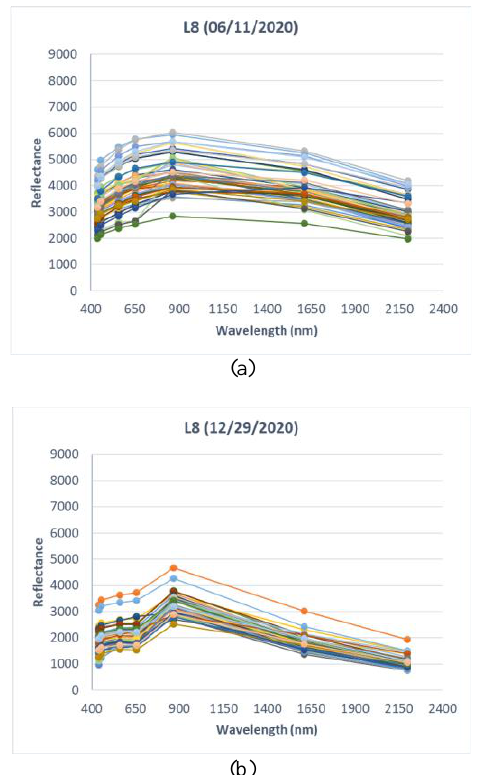
Figure 7 . Spectral signature plots extracted from L8 images for each of the 50 PCG samples. (a) Summer period. (b) Winter period.